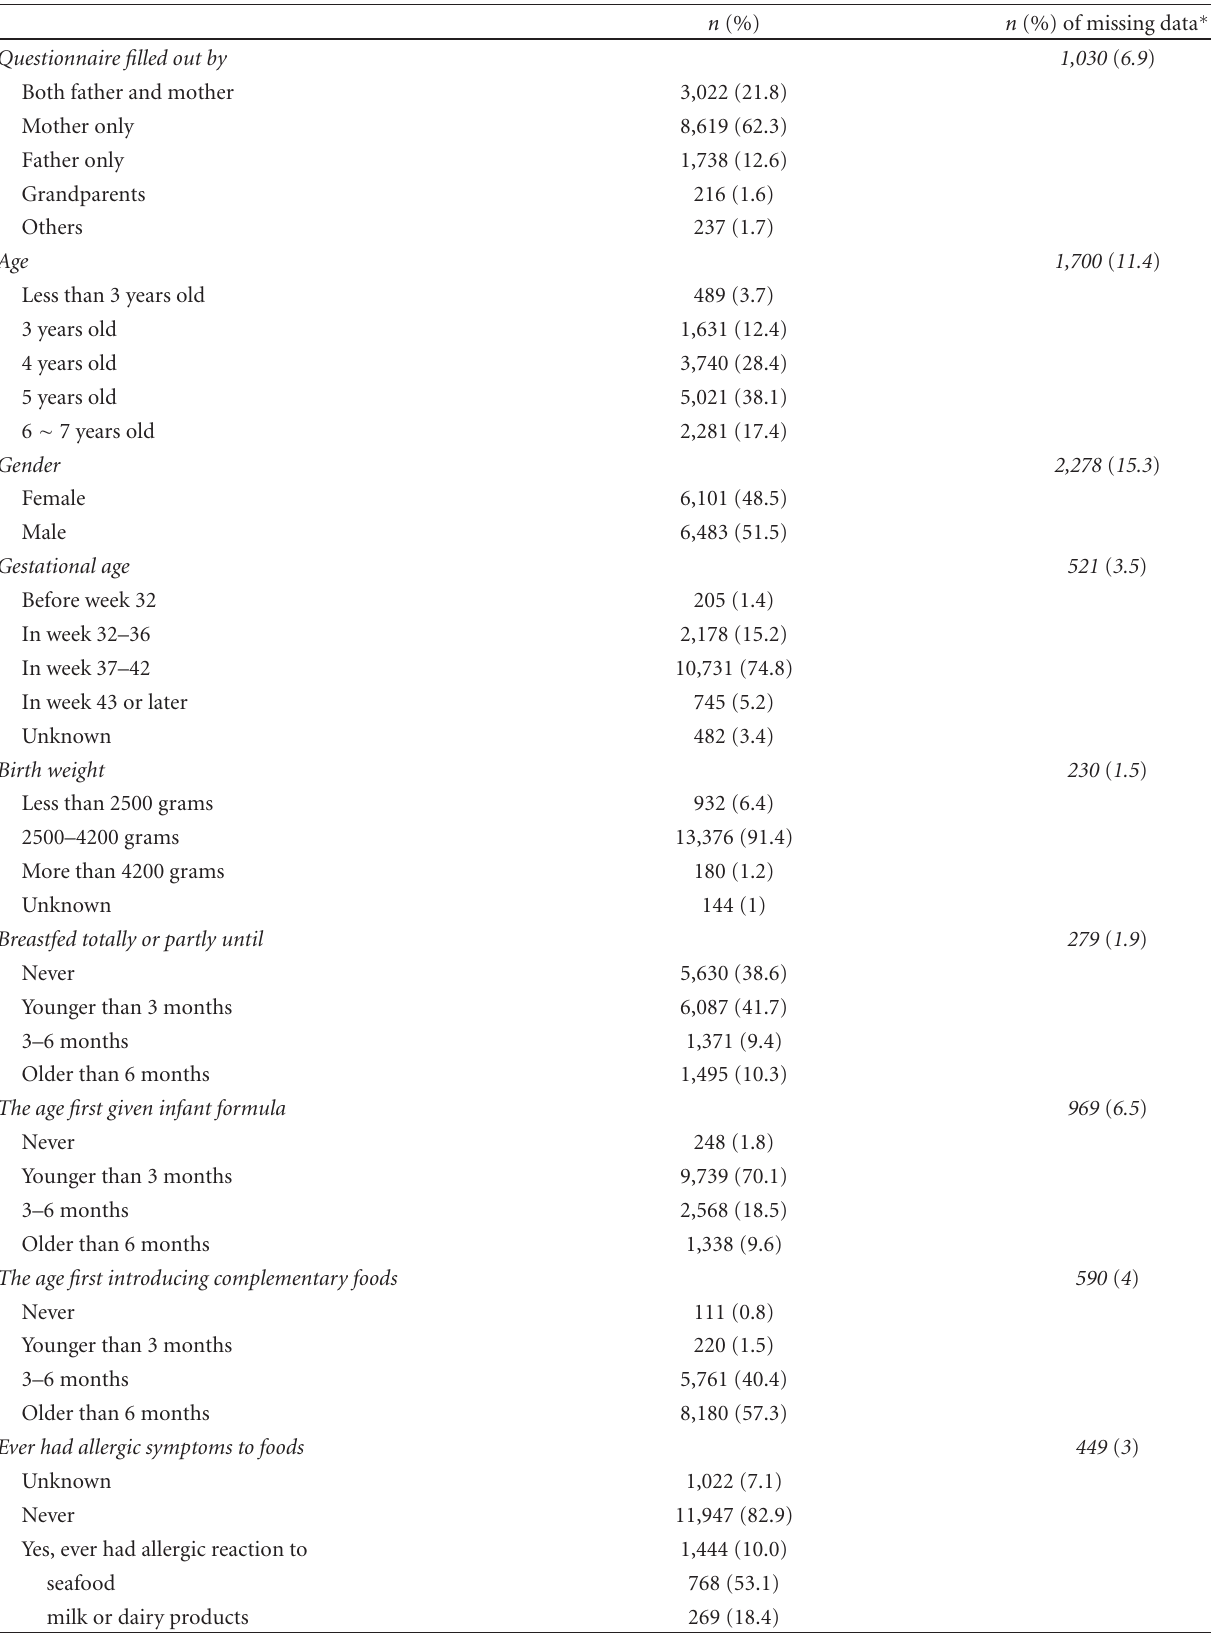
Table 1: Characteristics of study